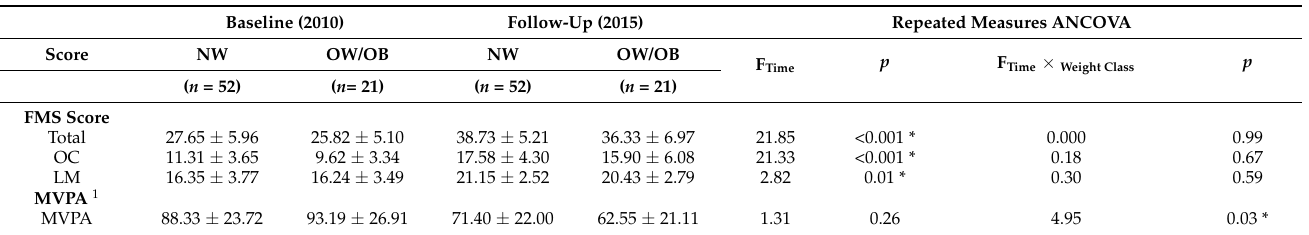
Note: OC, object-control; LM, locomotor; NW, non-overweight; OW/OB, overweight/obese. All analyses corrected for age, deprivation score, ethnicity and participation in intervention group. 1 Further adjusted for weather and monitor wear time. * Significant at p <